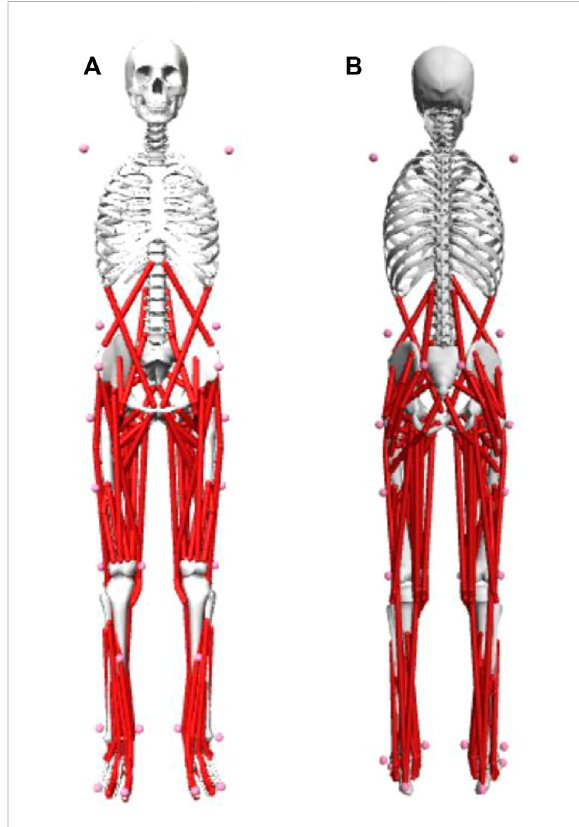
FIGURE 1 Schematic representation of the placements of the marker. (A) The front vision of the marker set; (B) the back vision of the marker